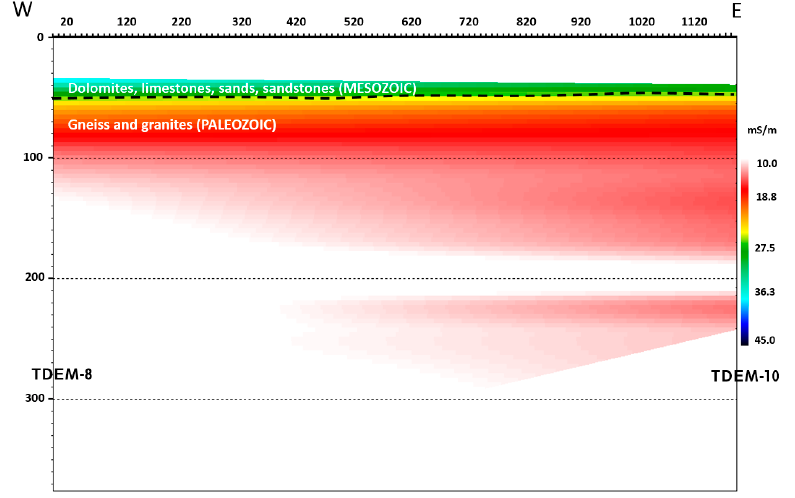
Figure 8. Two-dimensional interpretation of electromagnetic prospecting, TDEM-profile 3.